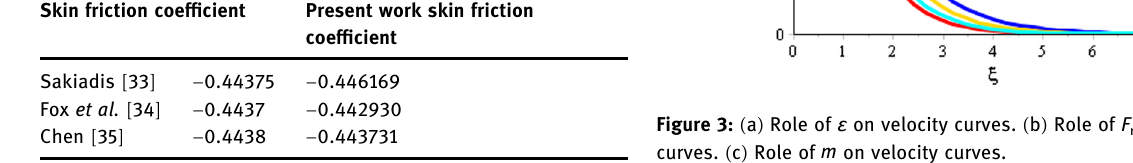
Table 3: Validation of numerical results for skin friction coe ffi cient Skin friction coe ffi